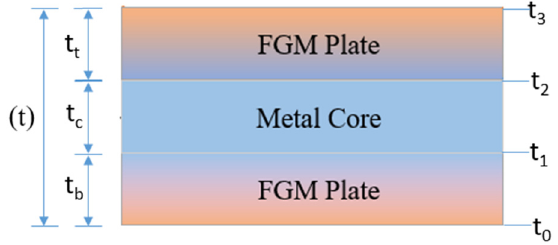
Figure 2: The geometry of a SFGM plate with metal